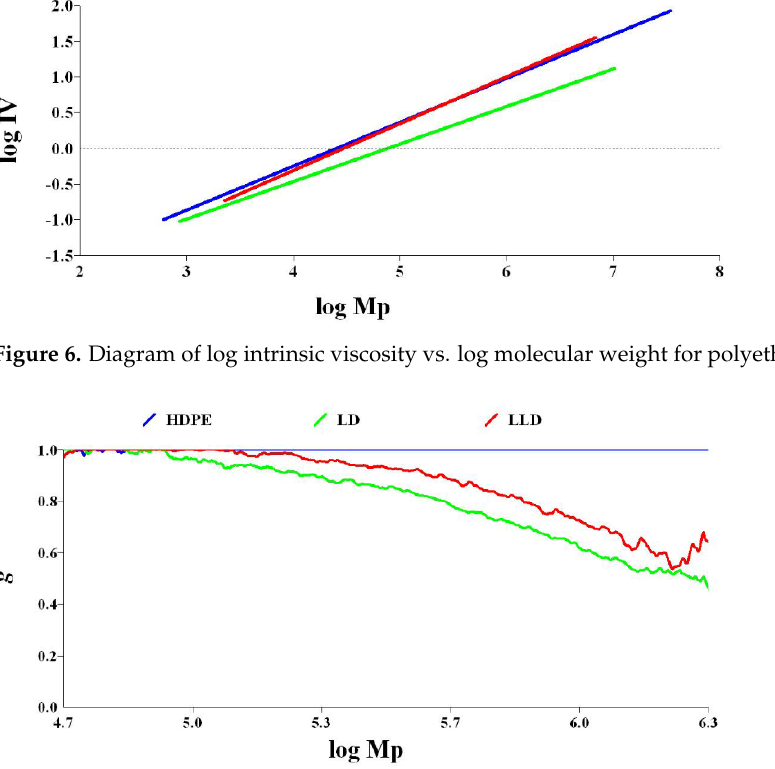
Figure 8. Diagram of branching number vs. log molecular weight for polyethylenes. The ratio between the intrinsic viscosity or radius of gyration of the branched pol- ymer and the linear polymer can be used to calculate values of g’ (the intrinsic viscosity contraction factor) or g (the radius of gyration contraction factor), respectively, according to the following equations: 𝑔𝑔′ = ( 𝐼𝐼𝐼𝐼 𝑏𝑏𝑏𝑏𝑏𝑏𝑏𝑏𝑐𝑐ℎ𝑒𝑒𝑒𝑒 𝐼𝐼𝐼𝐼 𝑙𝑙𝑙𝑙𝑏𝑏𝑒𝑒𝑏𝑏𝑏𝑏 ) (6) 𝑔𝑔 = ( 𝑅𝑅𝑔𝑔 𝑏𝑏𝑏𝑏𝑏𝑏𝑏𝑏𝑐𝑐ℎ𝑒𝑒𝑒𝑒 𝑅𝑅𝑔𝑔 𝑙𝑙𝑙𝑙𝑏𝑏𝑒𝑒𝑏𝑏𝑏𝑏 ) (7) where ′ = 𝑔𝑔 𝜀𝜀 , and ε (structure factor) = 0. 5–1.5—usually 0.75. The value g can then be input into various structural models (number average ternary-branching model; see Equation (8)) to estimate the B n . 𝑔𝑔 = [(1 + 𝐵𝐵 𝑏𝑏 7 ) 1 2� + 4 𝐵𝐵 𝑏𝑏 9 𝜋𝜋 ] −1 2� (8) 3.3.2. Rheology In order to completely characterize the samples, the rheology of the samples was investigated by oscillatory frequency sweep tests. Figure 9 shows the diagrams of storage modulus G’ and loss modulus G” in terms of angular frequency ω ( rad/s). By increasing the angular frequencies, the crossover point (COP) between the G’ and G” curves indi- cates a transition from a more viscous-like deformation behavior to a more elastic-like deformation behavior. Therefore, the COP is a criterion for qualitative product charac- terization. One of the most important pieces of information we can get from the position of the COP is a qualitative measurement of a polymer’s average molecular weight.